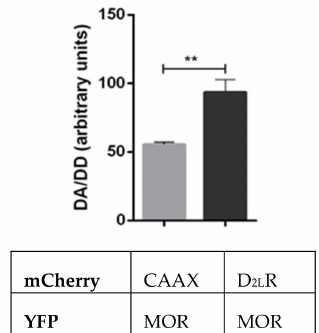
Figure 5. Analysis of D 2L R dimerization with MOR using Förster Resonance Energy Transfer (FRET). HeLa cells were transfected with pMOR-YFP, and either pD 2L R-mCherry or pmCherry-CAAX. Donor–acceptor (DA) / donor–donor (DD) ratios were determined under identical imaging conditions